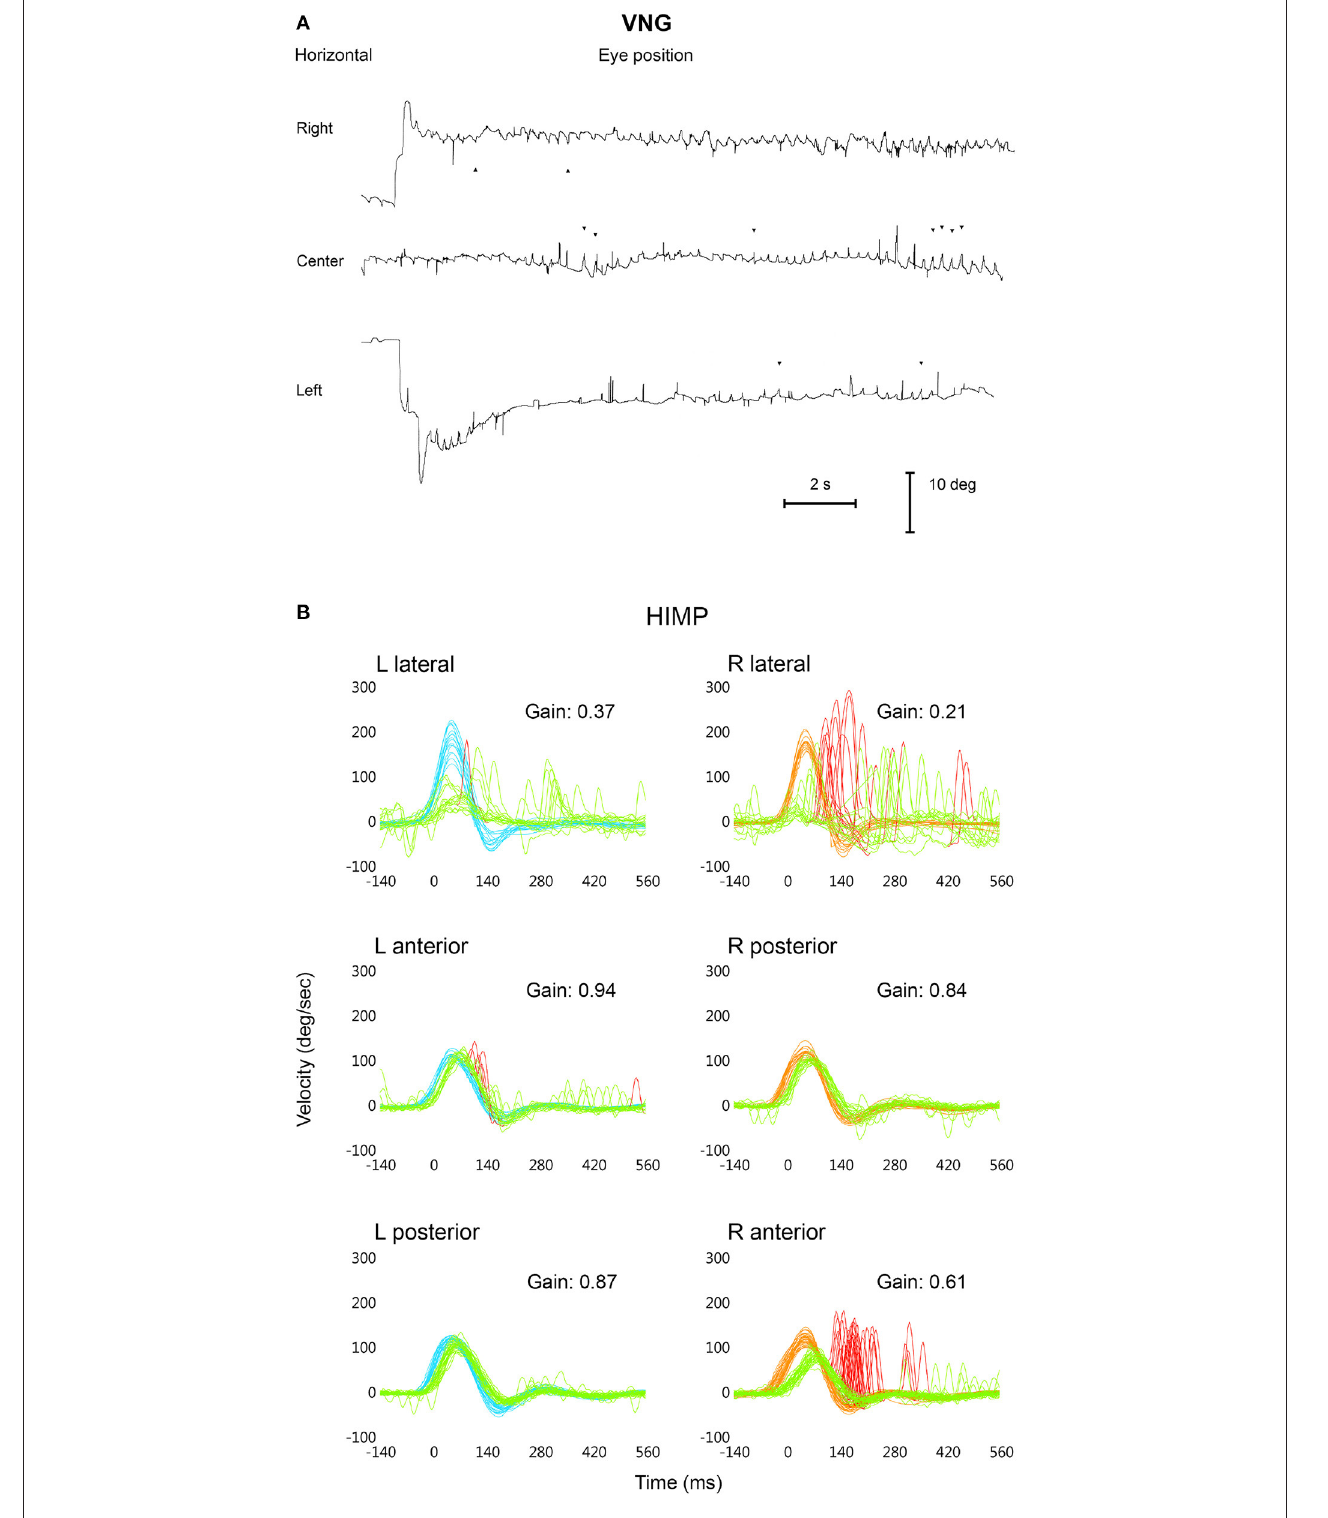
FIGURE 1 | Horizontal videonystagmography (VNG) recording of the left eye showing the congenital nystagmus looking to the right (upward), to the center, and to the left (downward) (A) . vHIT superimposed head [right: red; left: blue] and eye [green] velocity records in degrees/second ( y axis) vs. time in ms ( x axis) during HIMP trials for each semicircular canal, including mean values for VOR gain; the “Spontaneous Nystagmus” check box was not selected (B) .